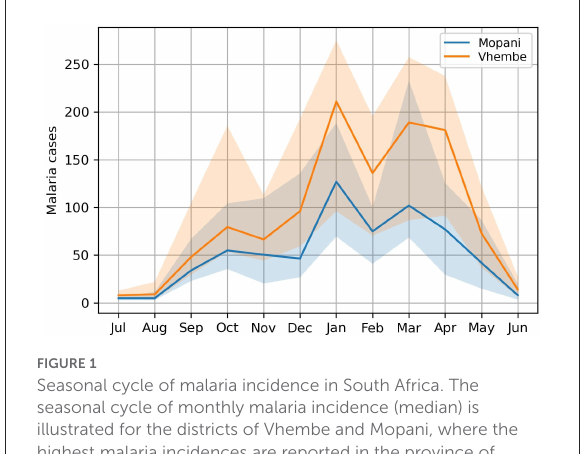
FIGURE1 Seasonal cycle of malaria incidence in South Africa. The seasonal cycle of monthly malaria incidence (median) is illustrated for the districts of Vhembe and Mopani, where the highest malaria incidences are reported in the province of Limpopo, South Africa. The highest incidences are observed in austral summer when temperature and precipitation are favorable for the spread of malaria. Interannual variations as measured with the interquartile range (25th percentile to 75th percentile) are